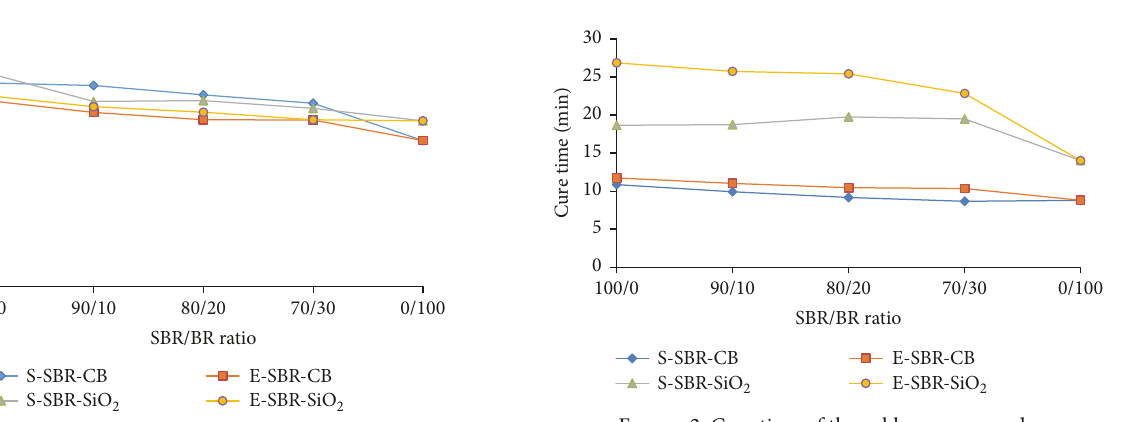
Figure 1: Mooney viscosity of the rubber compounds.